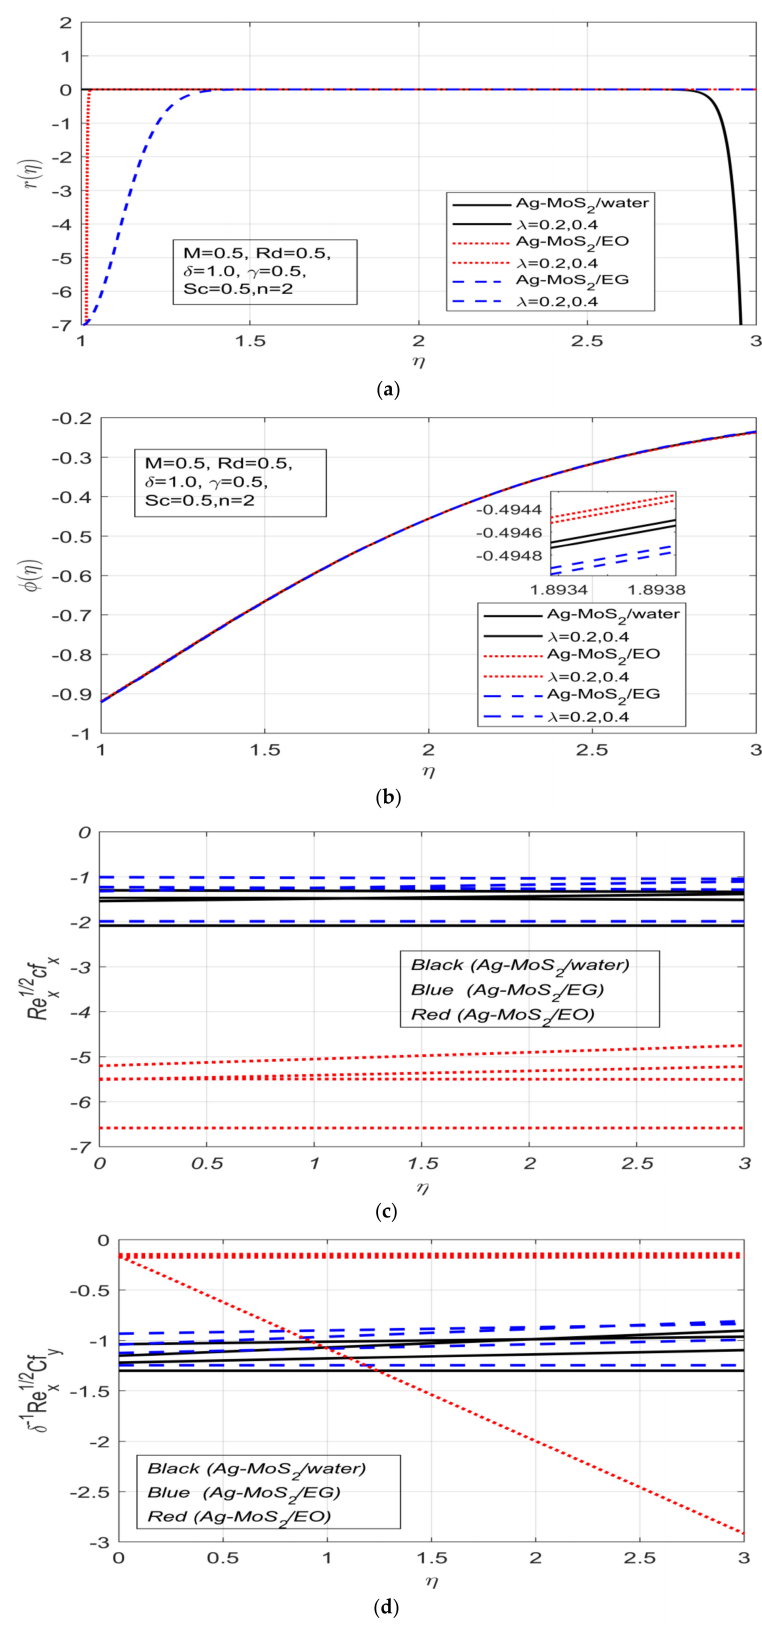
Figure 5. ( a ) The impact of rotation λ on the temperature profile r . ( b ) The impact of rotation λ on the concentration profile φ . ( c ) The behavior of skin friction in the x-direction for three cases. ( d ) The behavior of skin friction in the y-direction for three